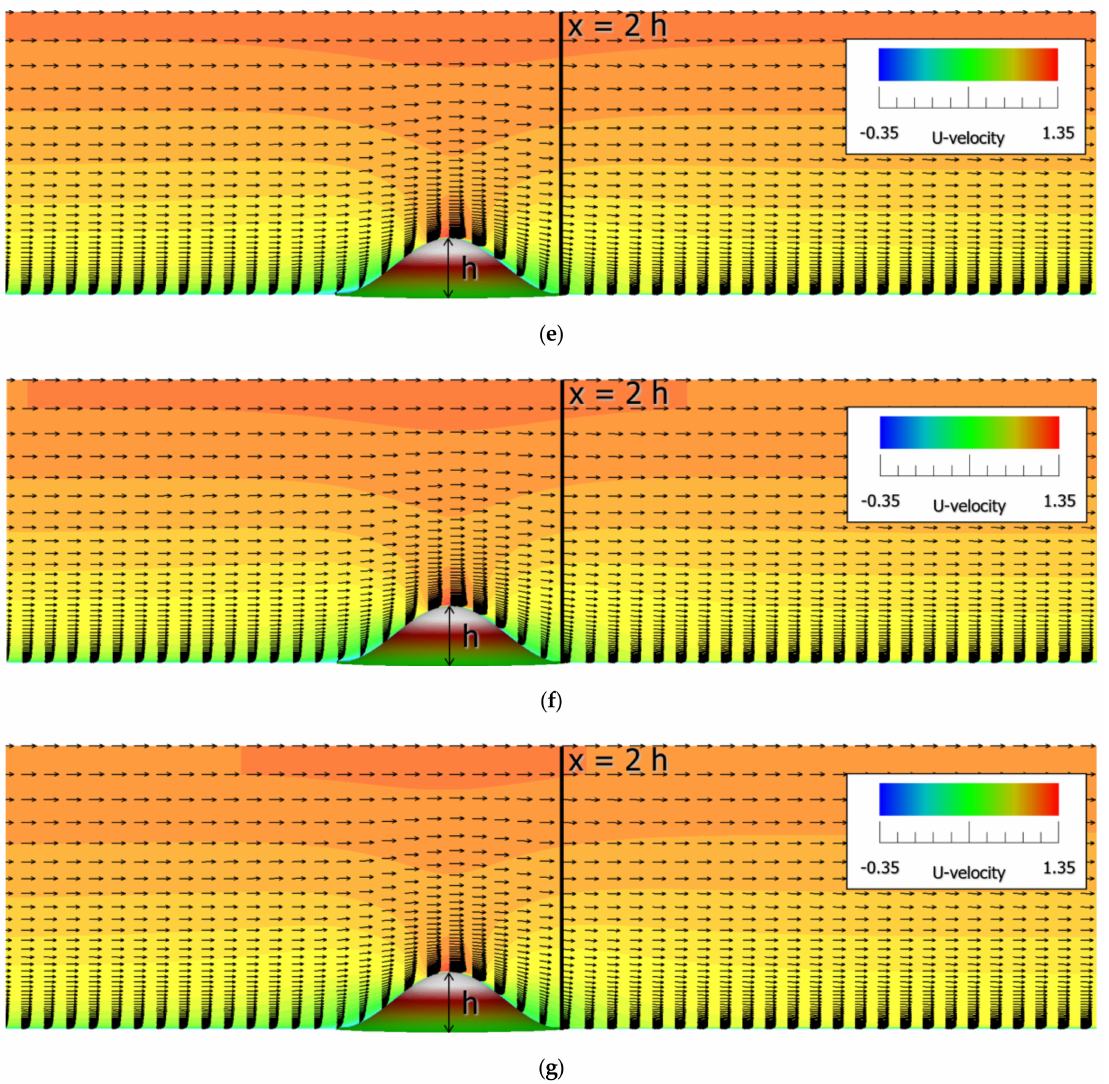
Figure 9. Comparison of instantaneous flow patterns of fully developed flow field under various stable conditions in the steep hill scenario. Ri—Richardson number. ( a ) Ri = 0.0 (neutral flow); ( b ) Ri = 0.2 (stable stratified flow); ( c ) Ri = 0.4 (stable stratified flow); ( d ) Ri = 0.5 (stable stratified flow); ( e ) Ri = 0.6 (stable stratified flow); ( f ) Ri = 0.8 (stable stratified flow); ( g ) Ri = 1.0 (stable stratified flow).